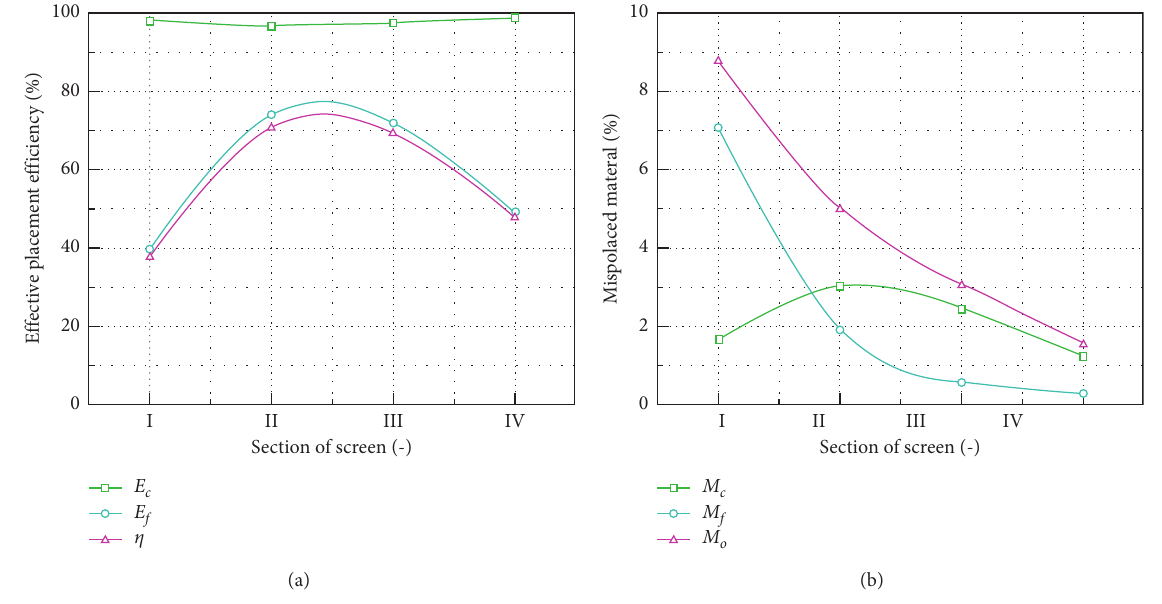
Figure 12: Screening performance of different sections of the VFFS.